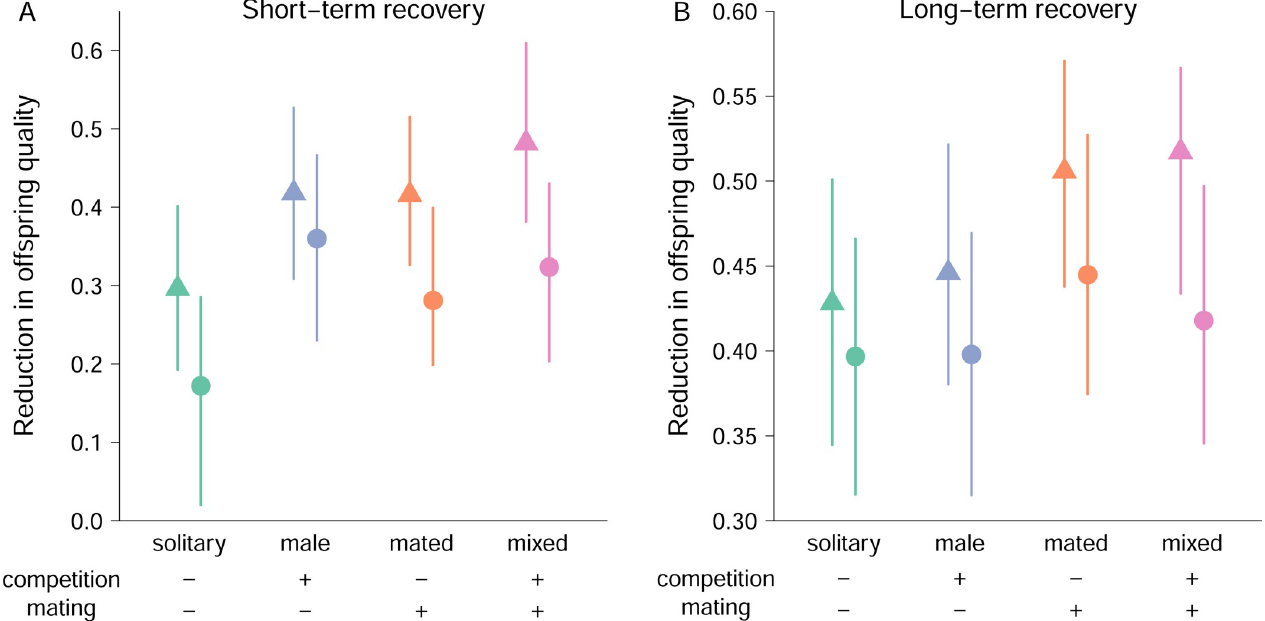
Fig 3. Estimates of germline maintenance in males with an evolutionary history of intense sexual selection. Reduction in offspring quality (1- [F2 IRRADIATED /F2 CONTROL ]) after short-term ( A ) or long-term ( B ) recovery of males from 2 S lines (S1: triangles, S3: circles). Males were held in one of 4 different social environments before irradiation: solitary, without any competitors or mating partners (solitary, green symbols); without mating partners but with 4 male competitors (male, blue symbols); without competitors but with 1 female mating partner (mated, orange symbols); or with 4 male competitors and 5 female mating partners (mixed, pink symbols). Values are Bayesian posterior means and 95% credible intervals. The data underlying this figure can be found in “F2_short.txt” ( A ) and “F2_long.txt” ( B ) at Mendeley Data